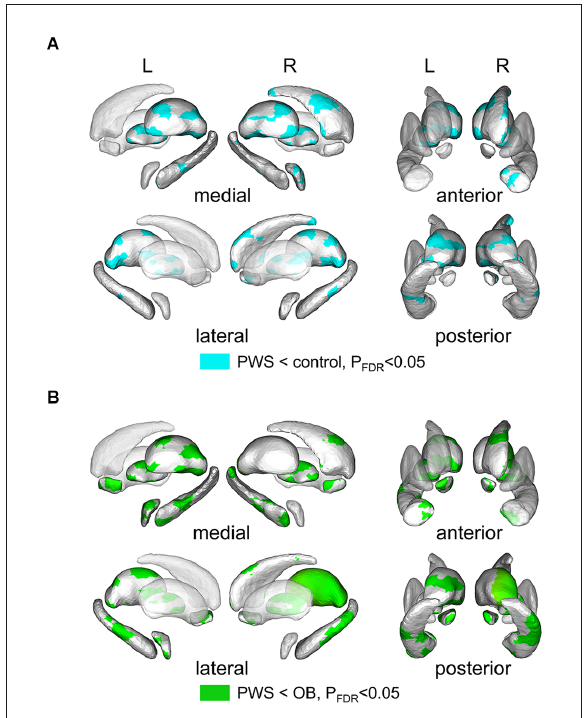
FIGURE2 Results of shape analysis in cerebral nuclei, shown from medial, lateral, anterior, and posterior views. (A) Atrophic subregions (cyan color) of PWS compared with the control. (B) Atrophic subregions (green color) of PWS compared with OB. PWS, children with Prader-Willi Syndrome; OB, obese children without PWS.